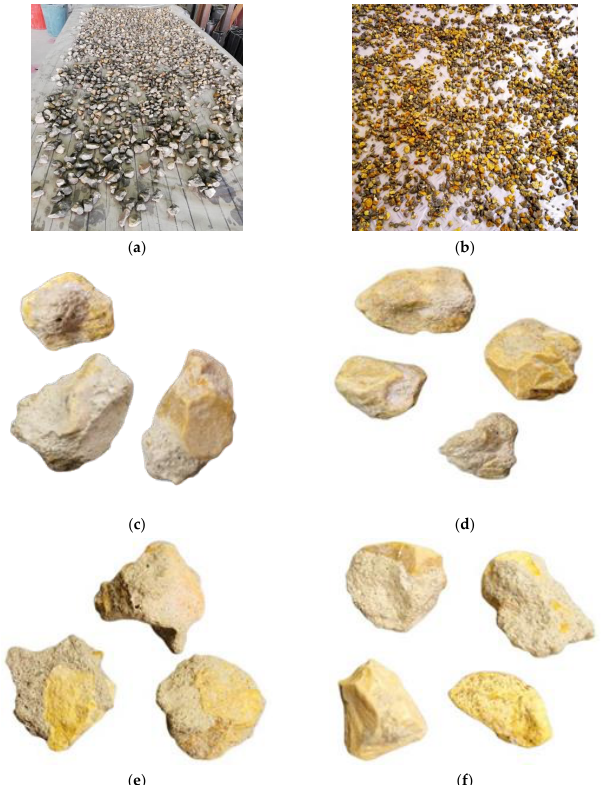
Figure 3. Treatment of RCA using sodium-silicate solution ( a ) Untreated RCA; ( b ) Treated RCA using 40% concentration of sodium-silicate solution after drying; ( c – f ) RCA treated using 20%, 30%, 40% and 50% concentration of sodium-silicate solution.